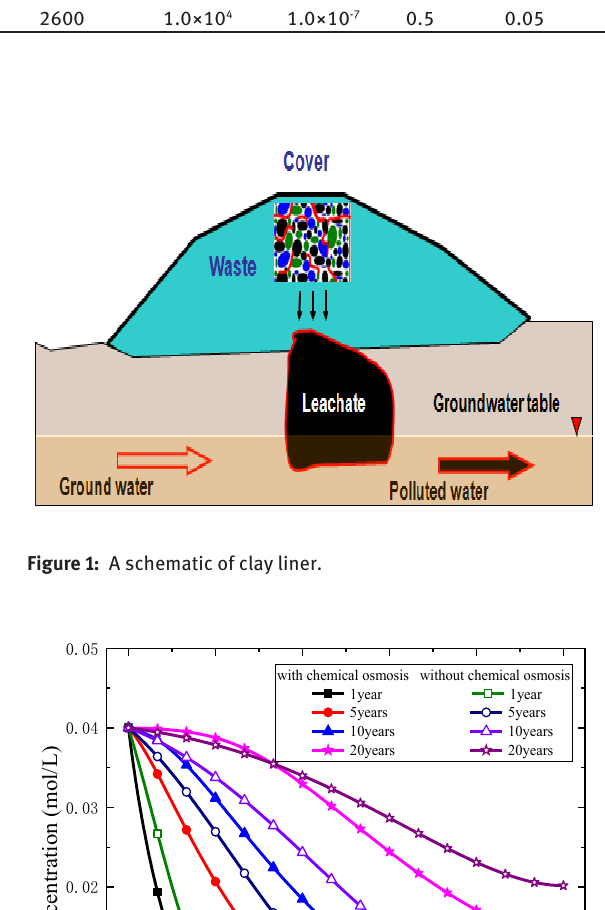
Table 1: Model parameter.